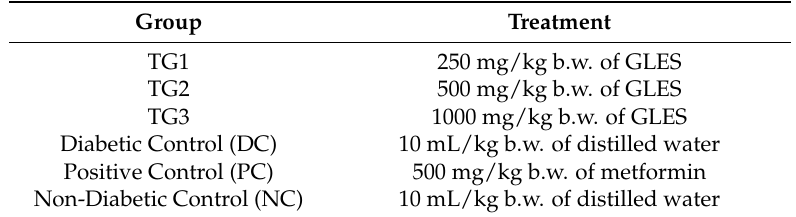
Table 2. Animal Grouping: Sub-chronic treatment with Gongronema latifolium